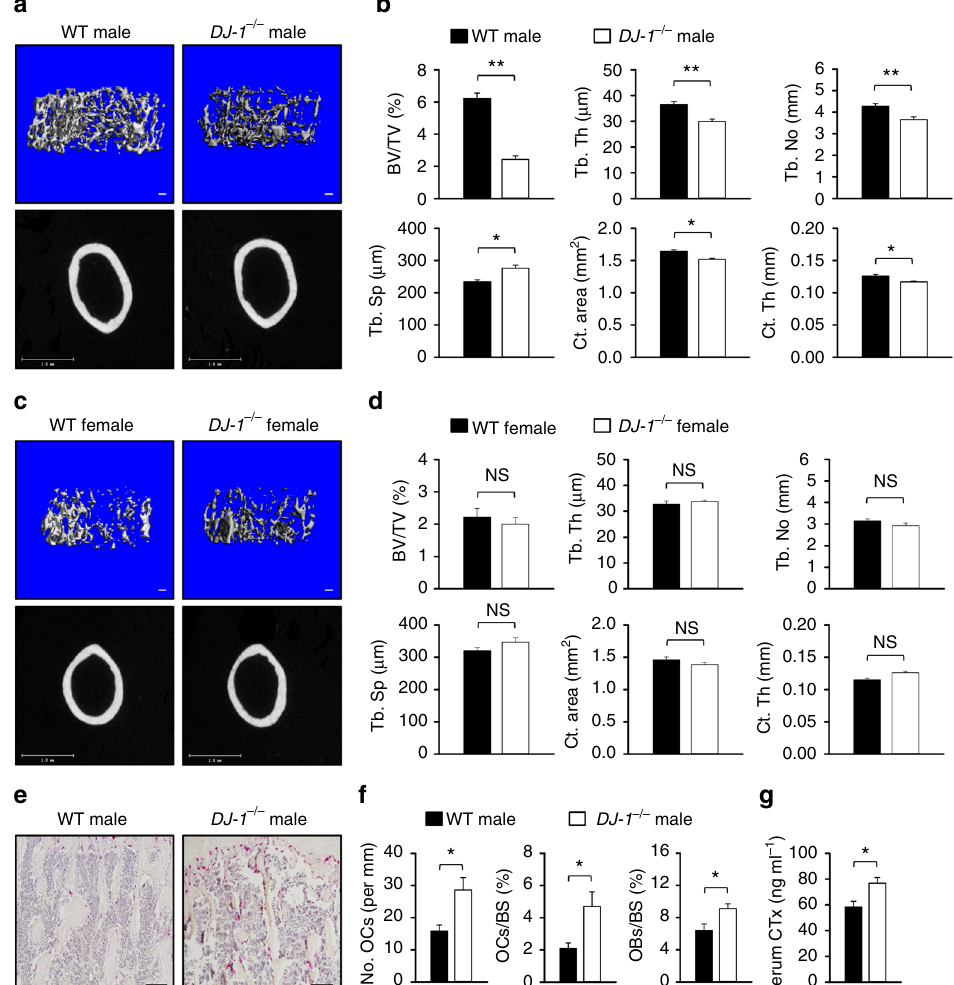
Fig. 1 Decreased bone volume and increased OC number in DJ-1 − / − mice. a , c Representative microCT images of trabecular (Tb) and cortical (Ct) bone from WT or DJ-1 − / − male and female mice (both 10 weeks old, n = 6 per group, Scale bar; Tb 100 μ m, Ct 1 mm). b , d Quanti fi cation of trabecular bone volume per tissue volume (BV/TV), Tb thickness (Th), number (No), spacing (Sp), Ct area, and Ct Th in femur tissues. e Representative images of femur from WT or DJ-1 − / − male mice that were stained with TRAP. Magni fi cation, ×100 and scale bar, 100 μ m, n = 6 per group. f Histomorphometric analysis of OCs number, OCs surface and OBs surface in femur tissues. g The measurement of serum collagen degradation product (CTx) in WT or DJ-1 − / − mice. b , d , f , g The data shown as the mean ± s.e.m. n = 6 per group. ** p < 0.01, * p < 0.05, NS, not signi fi cant vs. WT by Student ’ s t